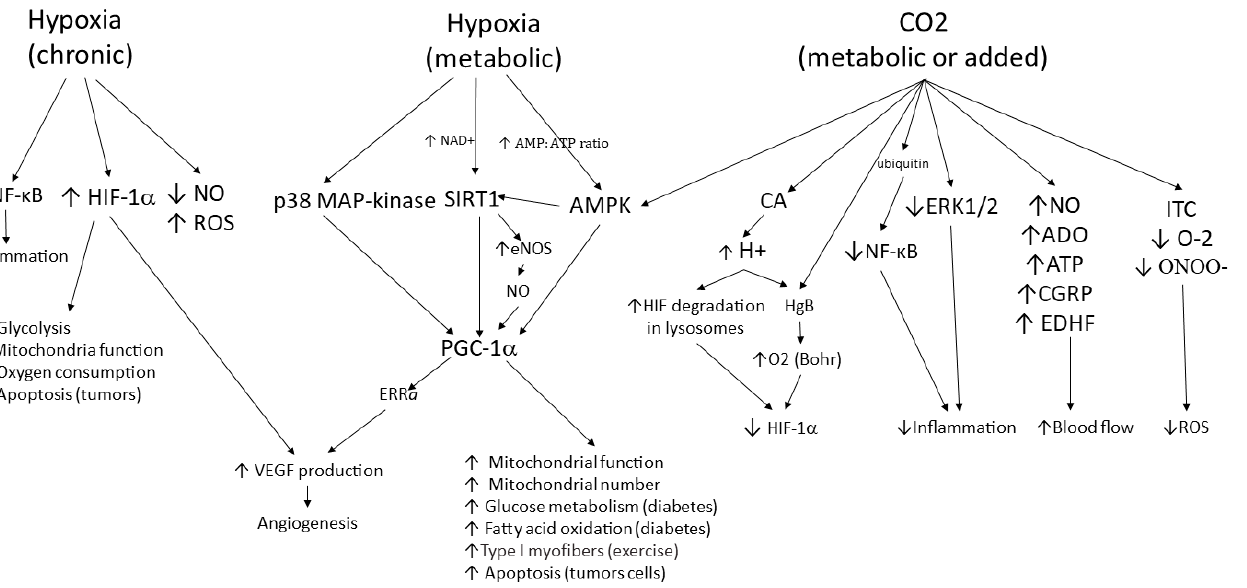
Figure 2. Tissue response to hypoxia and carbon dioxide. This chart shows the molecular pathways that are involved in the tissue response to hypoxia and elevated CO 2 levels. Three pathways are shown. The first two are tissue responses to hypoxia. Normal metabolic control of hypoxia initially involves the moment-to-moment response to O 2 demands by alterations in blood flow. If demand persists, pathways for improving O 2 supply are activated. Multiple pathways lead to the activation of PGC-1 α , which induces metabolic changes and new blood vessel formation to allow the tissue to continue to thrive. If hypoxia is persistent and/or severe, as seen in pathological conditions, the left pathway is also activated. Cells experience increased inflammation and oxidative stress and activate HIF-1 α -induced production of VEGF to further stimulate neovascularization and increase blood flow while also altering cell metabolism to reduce cell death (i.e., stimulate survival mode). The right pathway shows the responses activated by increases in tissue CO 2 . When blood flow is limited, CO 2 levels rise and trigger activation of AMPK, stimulating the tissue to respond with changes in cell metabolism and neovascularization that allow the tissue to thrive. Multiple additional pathways are stimulated by elevated CO 2 , resulting in increased blood flow, decreased inflammation, decreased oxidative stress, as well as a reduction in survival pathways stimulated by HIF-1 α . Thus, elevated CO 2 levels (either metabolically generated or brought about by therapeutic CO 2 delivery) will produce a more homeostatic state in the